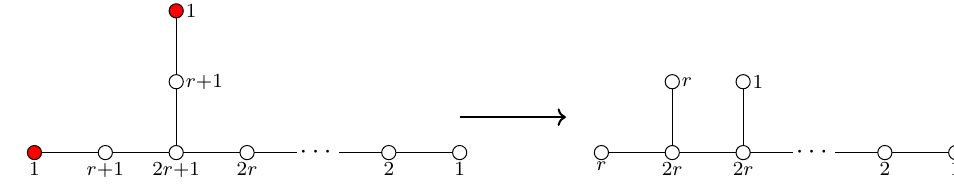
Figure 11. The FI deformation leading from the magnetic quiver of the SO(4 r + 6) × U(1) SCFT to that of the low-energy theory USp(2 r ) with 2 r + 3